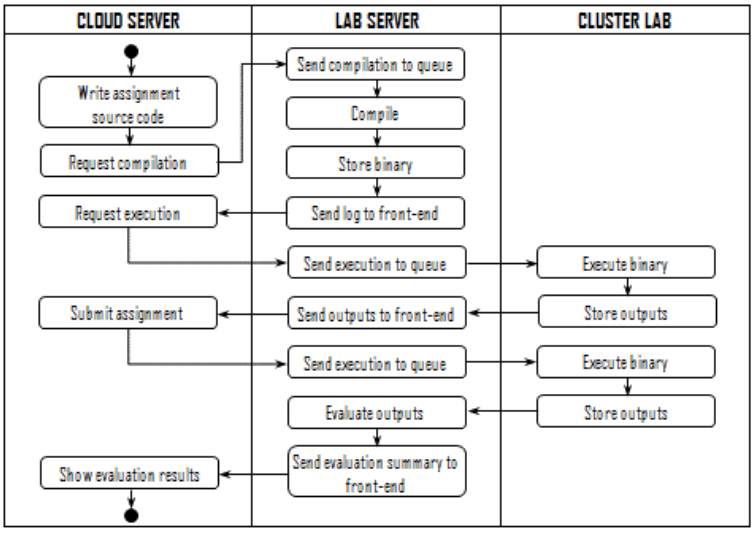
Fig. 2. Platform components interaction for a student assignment